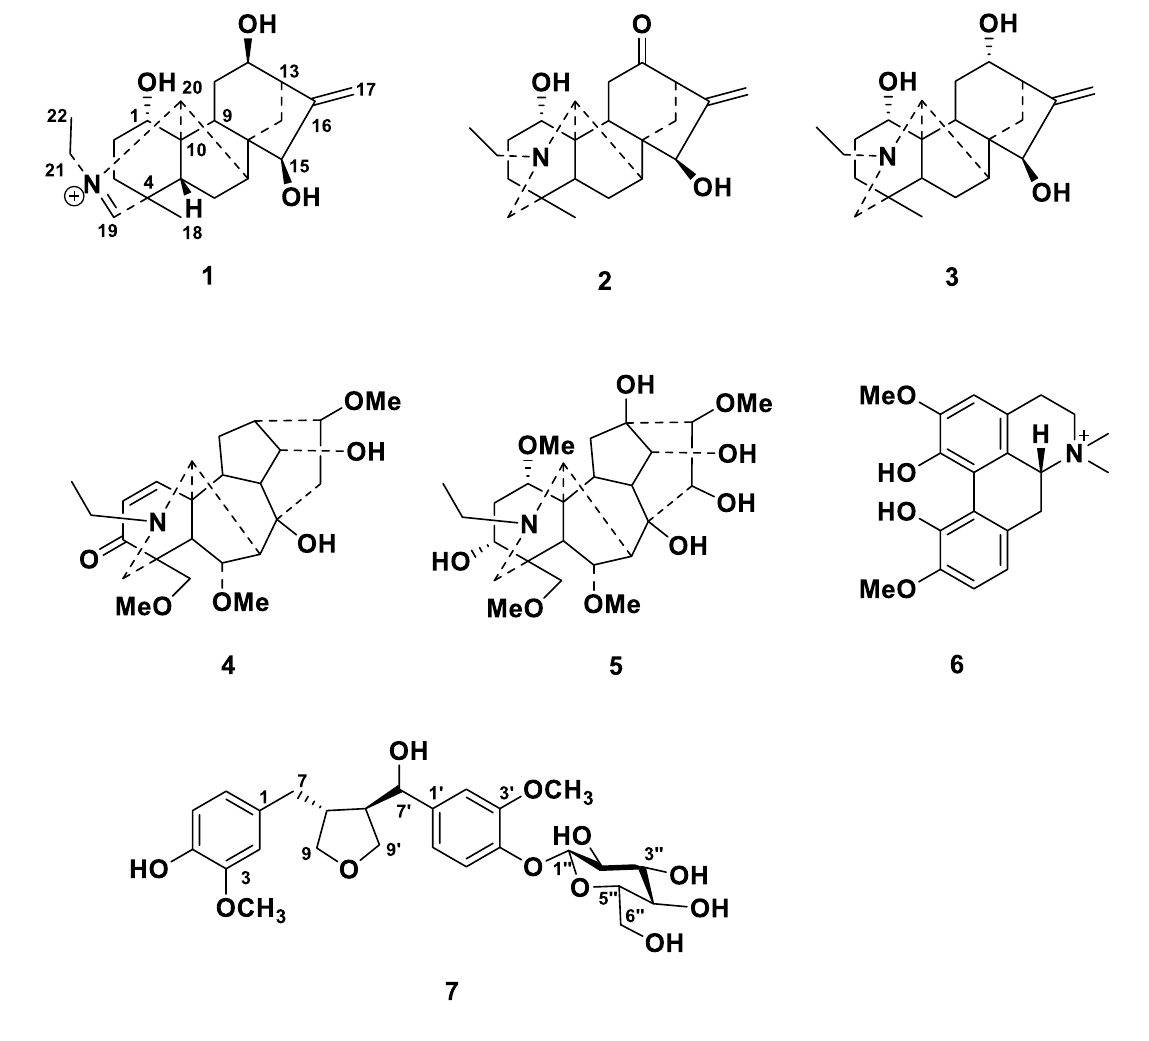
Fig. 1 Molecular structures of compounds 1 −